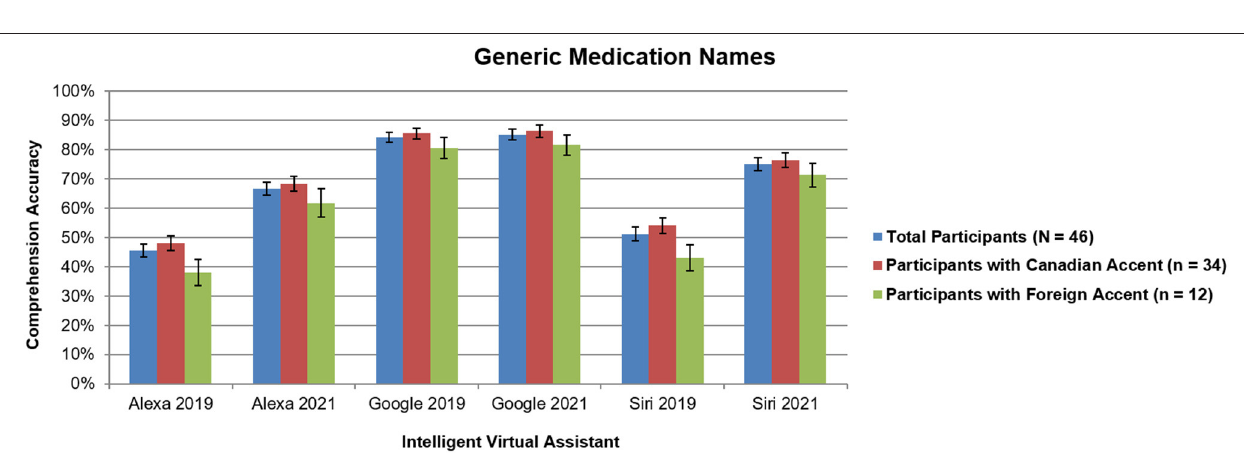
FIGURE 1 | Intelligent virtual assistant comprehension accuracy of brand names for the top 50 most dispensed medications in the United States across all participants ( N = 46) as a comparison between 2019 and 2021, shown with standard errors for each mean. Canadian accent participants ( n = 34); foreign accent participants ( n = 12). Percentages represent the average accuracy rates for participants across all 50 medication names. See text for more details.